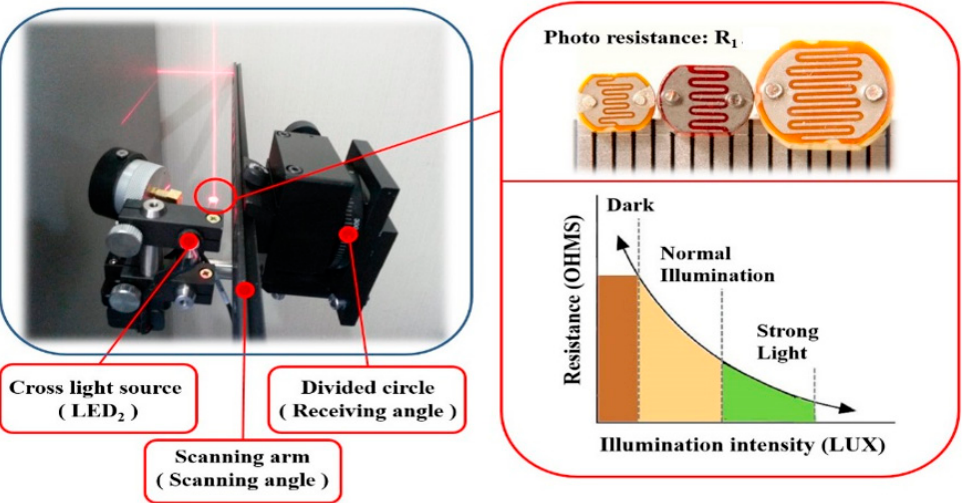
Figure 16. The actual settings of the automatic scanning robot arm.